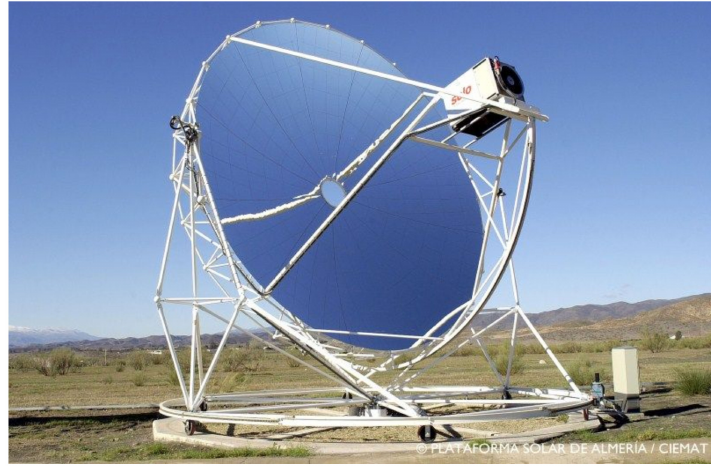
Figure 3. EuroDISH system, Almer í